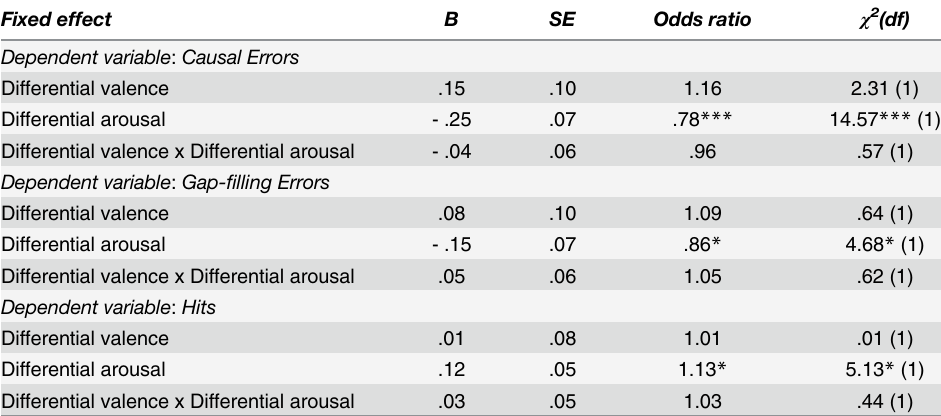
Table 4. Fixed effect of differential valence and differential arousal on Causal Errors, Gap-filling Errors, and Hits using logistic mixed-effects